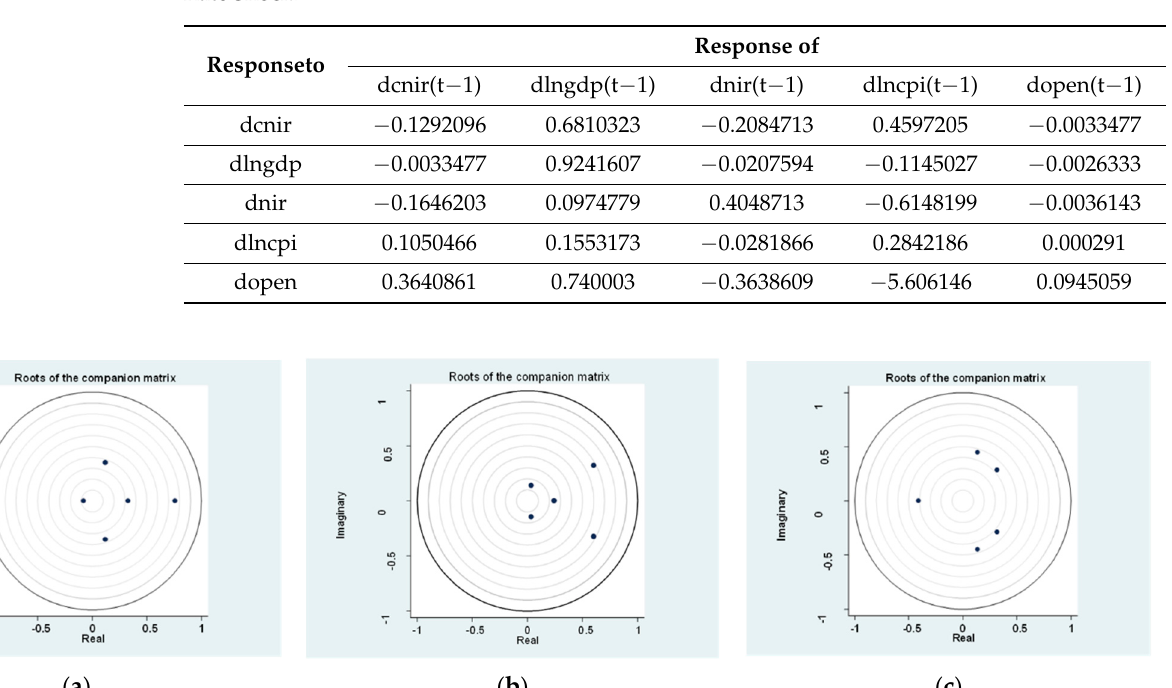
Table 6. Moment and Model Selection Criteria (MMSC) for Interest Rate Shock.